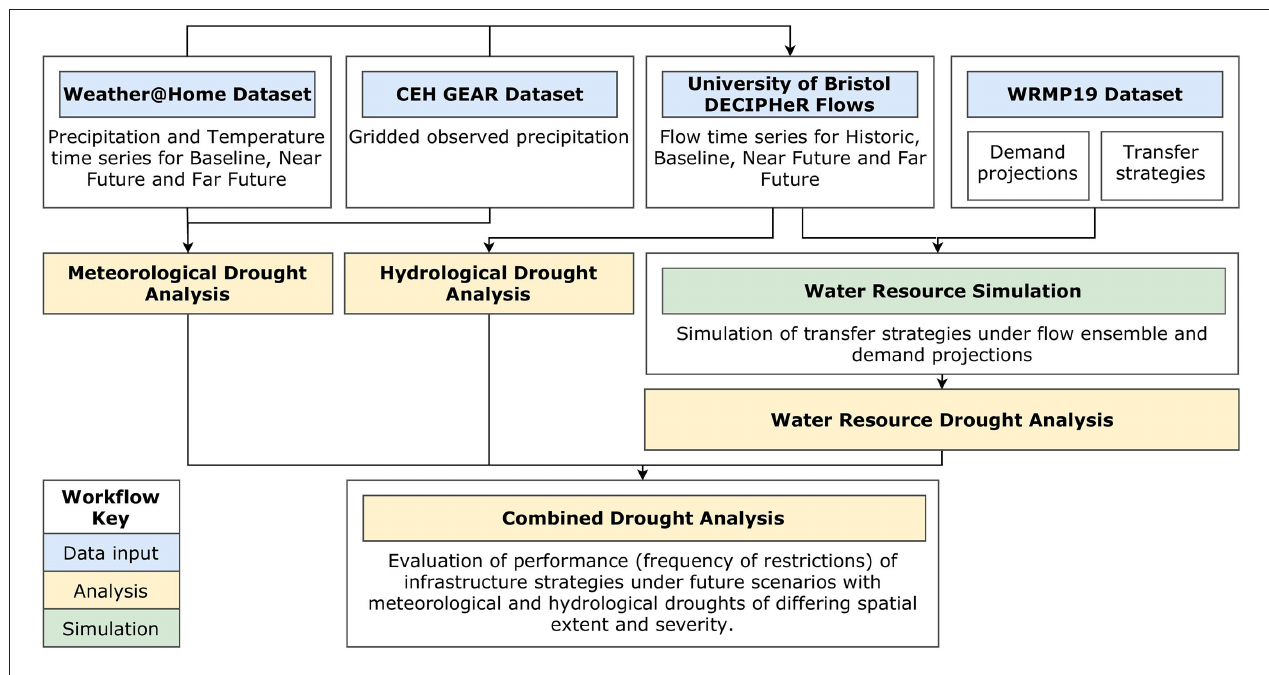
FIGURE 2 | Workflow with data sources, scenarios, and model outputs.